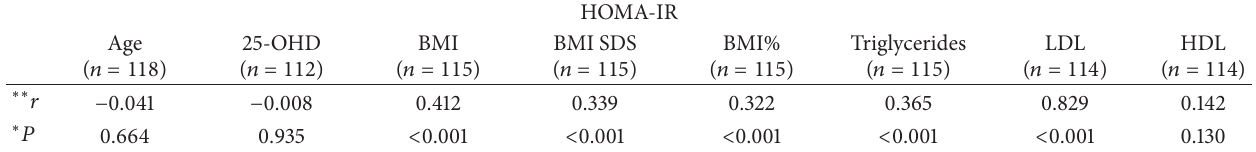
Table 4: Bivariate correlations between covariates among HOMA-IR in the obese group.